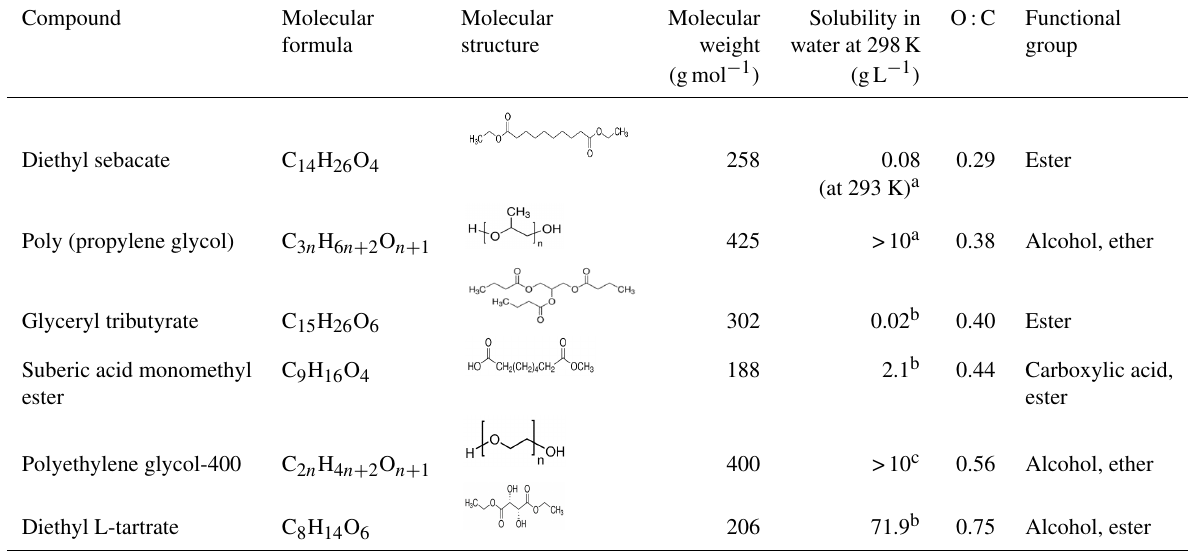
Table 1. Organic species studied, as well as molecular formula, molecular structure, molecular weight, solubility in water, oxygen-to-carbon elemental ratios (O:C), and functional groups of the species studied. All organic species are liquid at room temperature. Compound Molecular Molecular Molecular Solubility in O:C Functional formula structure